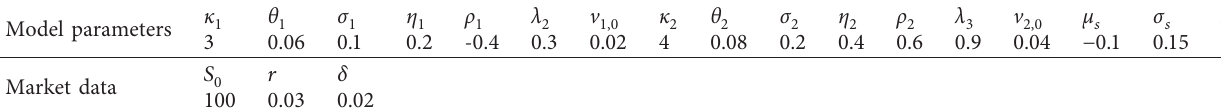
Table 1: Parameter settings for numerical examples.